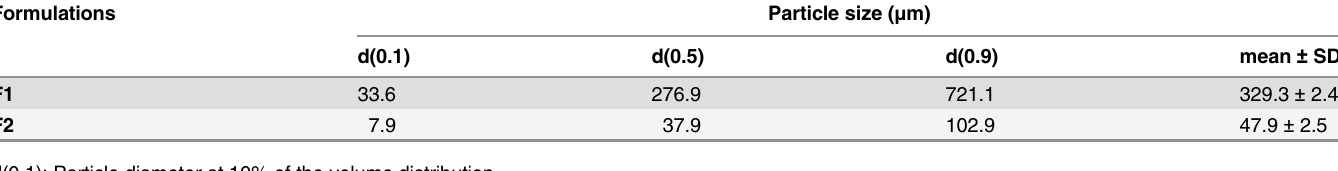
were set as presented in Table 2 during the HME process. Since the glass transition temperature ) of Soluplus is around 70°C and the heating zone of barrel can be set 15 – 60°C above the T (T g of the polymer [16], established temperatures in the barrel section seem to be appropriate. The degree of shear stress can be explained by SME. SME can be defined as the consump- tion of mechanical energy during extrusion process per mass flow rate [23]. It is dependent on the conditions of extrusion process such as screw speed, barrel temperature, water content, feed composition, and screw configuration. Different screw configuration used in this study can produce different degree SME values. As shown in Table 3, SME value was increased in the order of low < middle < high shear stress. To put AGN into the HME machine, the particle size of AGN powder was reduced. After coarse milling, the mean diameter of particles (F1) was 329.3 ± 2.4 μ m (Table 4). To further re- duce particle size, coarse powders (F1) were milled into ultrafine particles (F2), which have a milling processes is shown in the particle size distribution chart (Fig 2). The narrow size distri- bution of coarse and ultrafine particles (F1 and F2) is also presented. The particle size ranges of milled AGN powders have already been reported [11]. According to the SEM images of F1 and F2, an irregular shape was observed (S1 Fig). With ultrafine AGN particles (F2) processed by HME, oral AGN-based formulations were prepared according to the composition and process- ing conditions detailed in Tables 1 and 2. Due to the high surface area to volume ratio of F2 compared to F1, the HME process with ultrafine particles (F2) is expected to produce a more homogeneous dispersion of poorly water-soluble matrix components. Pulverized AGN Table 4. Particle size analysis of AGN powders after milling.